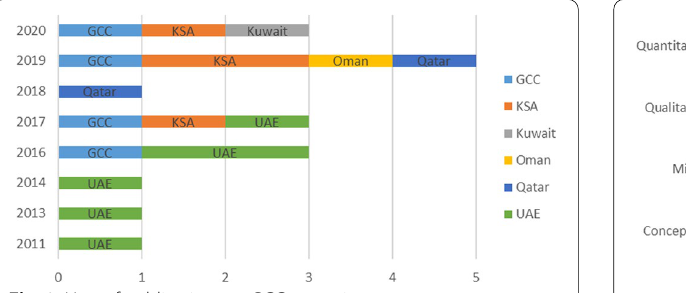
Fig. 9 Year of publication per GCC countries